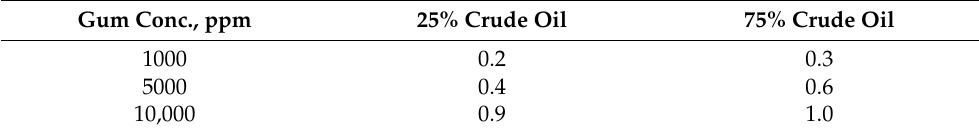
Table 1. Crude oil-gum emulsion critical frequency w c .